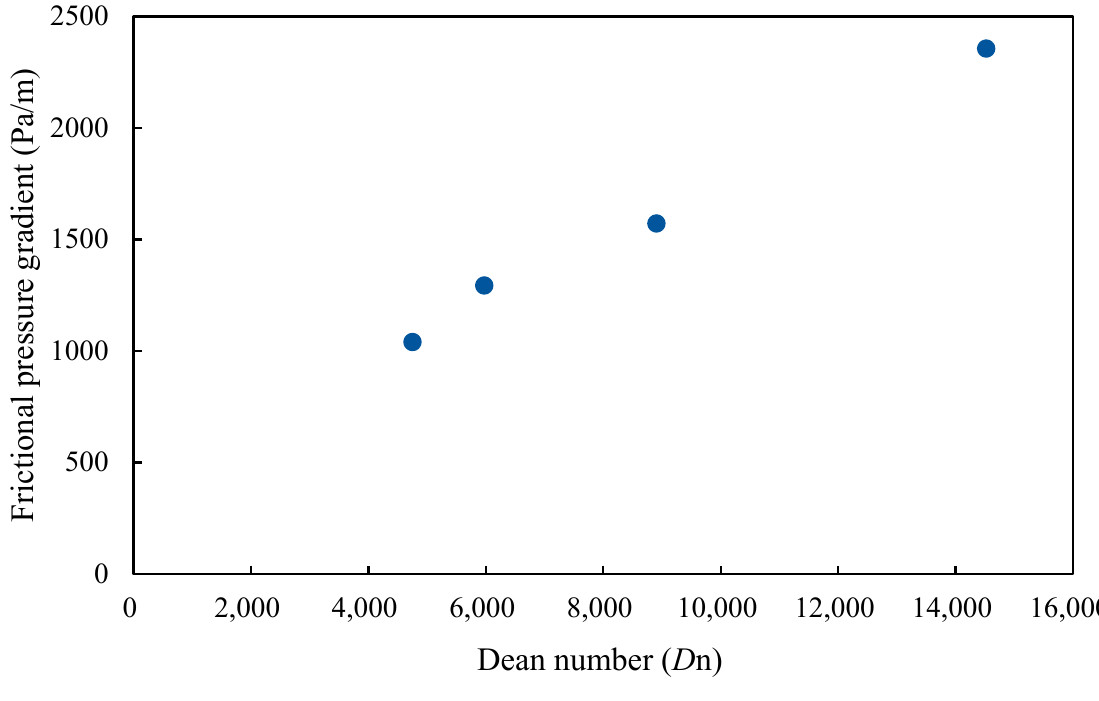
Figure 9. Average frictional pressure gradient with average Dean number. When the average Dean number of two-phase is 4800, the average frictional pressure gradient is 1040 Pa/m. When the Dean number increases to 8900, the average frictional pressure drop gradient is 1577 Pa/m, increasing by 430 Pa/m. Secondary flow intensity has little influence on friction. When the average Dean number increases to 14,500, the average frictional pressure gradient increases to 2350 Pa/m, and the difference is 1310 Pa/m. At this time, the influence of secondary flow on frictional pressure drop becomes